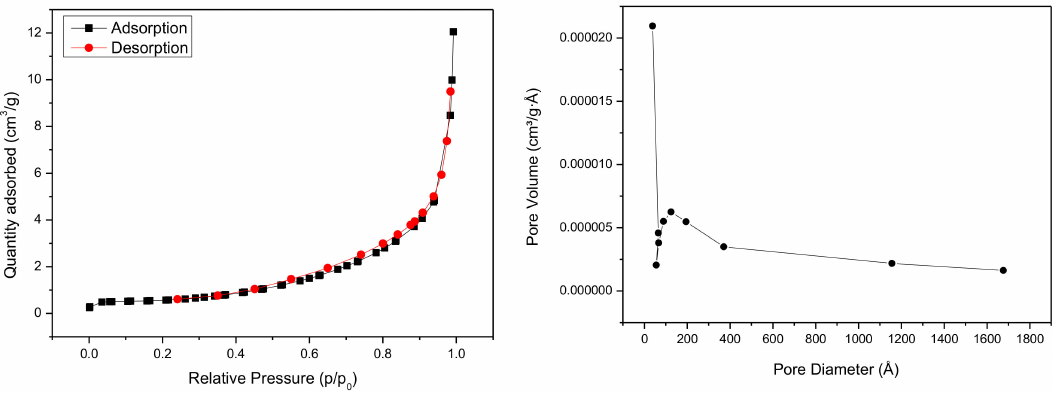
Figure 3. N 2 adsorption–desorption isotherm at − 196 ◦ C and BJH pore size distribution for the zeolite Zeo , derived from white